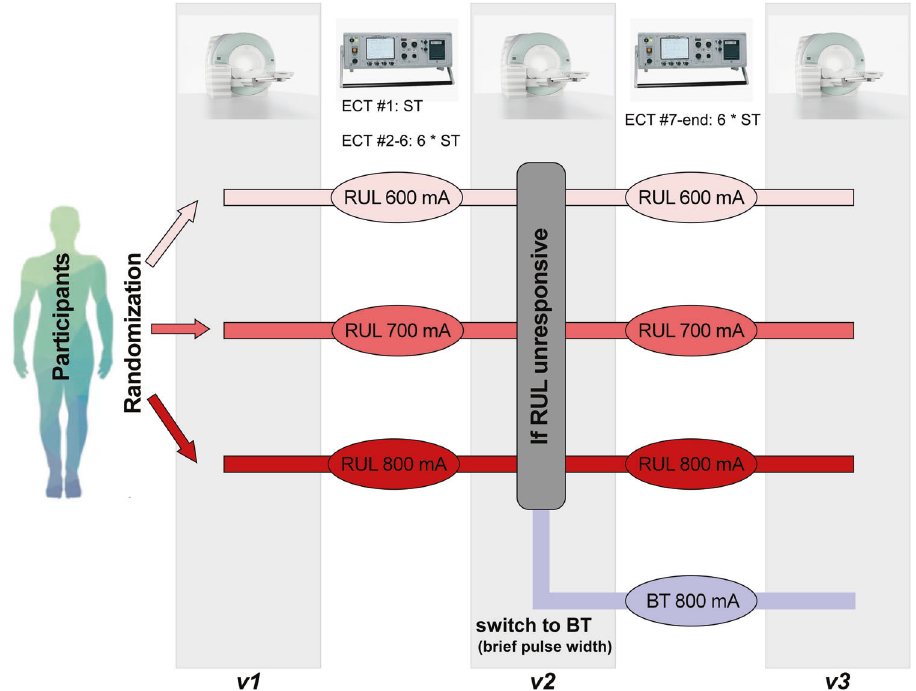
Fig. 1 Study design of the ECT data. Participants were randomized to 600, 700, and 800 mA pulse amplitudes and started the ECT series with RUL electrode placement. Participants received antidepressant ratings, neuropsychological assessments, and imaging sessions pre-ECT (v1), mid-ECT (v2), and post-ECT (v3). If participants had <25% reduction in v2 HDRS (compared to v1), they were switched to BT electrode placement with brief pulse width. ECT electroconvulsive therapy, mA milliamperes, RUL right unilateral, HDRS Hamilton Depression Rating Scale-24 item, BT